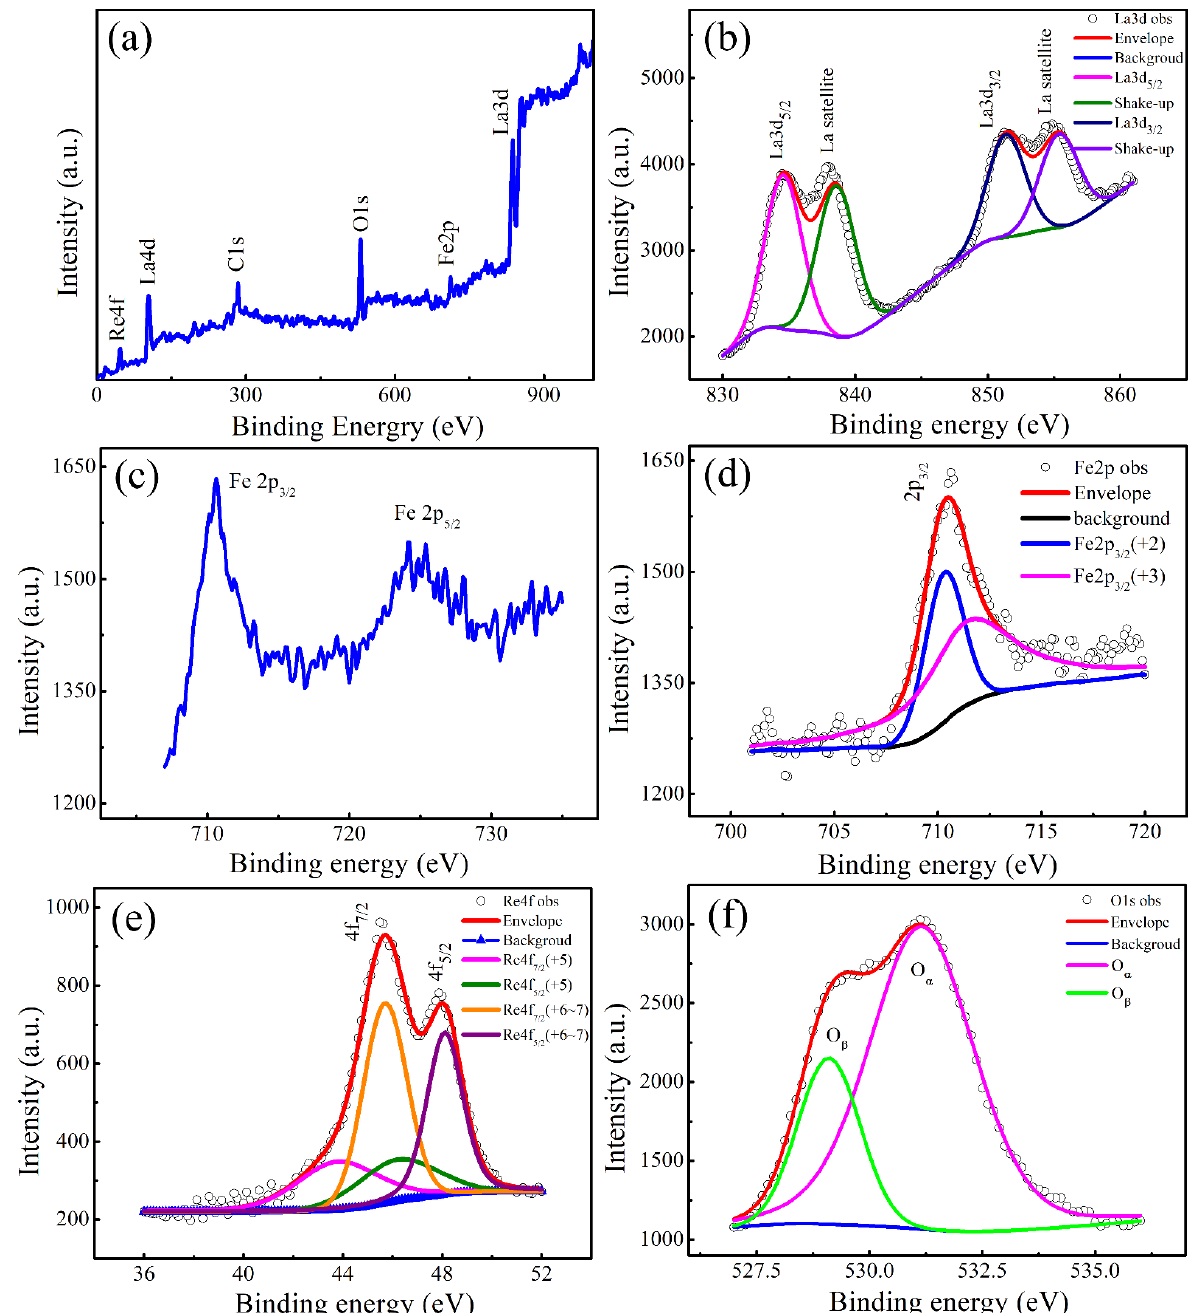
Figure 3. ( a ) Whole XPS spectrum of the as-synthesized LFRO powders; ( b ) local scan and peak fittings of La 3d XPS spectrum; ( c ) Fe 2p XPS spectrum and ( d ) the fitted Fe 2p 3/2 XPS spectrum; ( e , f ) local scans and peak fittings of Re 4f and O 1s XPS spectra, respectively.